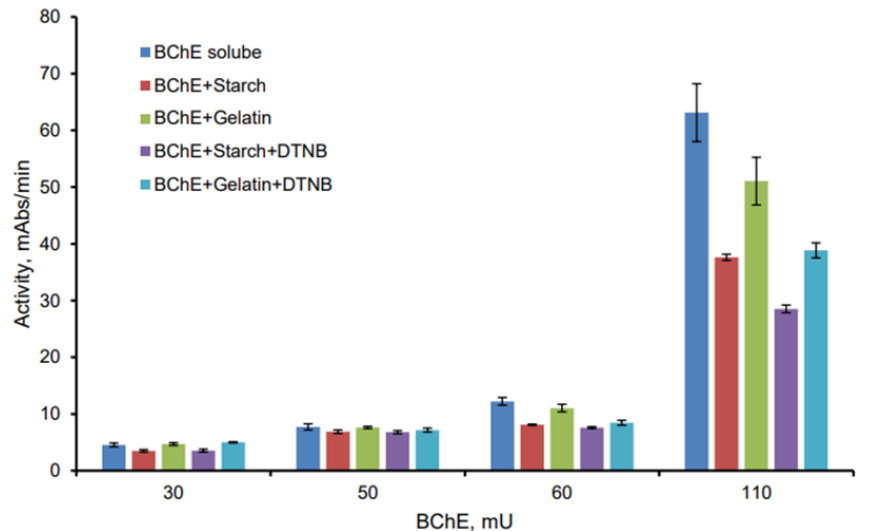
Figure 2. Activities of the immobilized BChE enzyme as dependent on the composition of the preparation. Activities of the preparations containing different amounts of BChE immobilized into the 3% starch gel or 1.4% gelatin gel and preparations with co-immobilized BChE and DTNB. DTNB concentration was 0.2 mM.